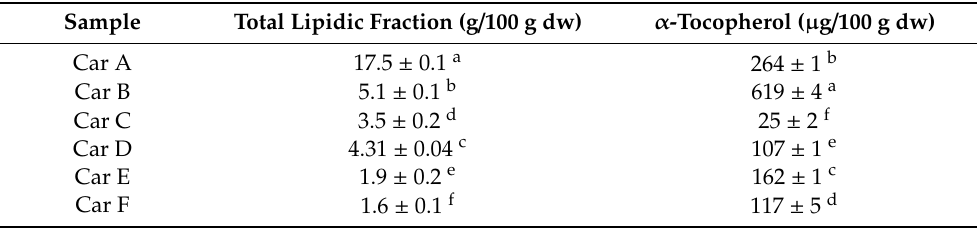
Table 1. Lipidic fraction and tocopherols of Cynara cardunculus heads at various stages of maturity (mean ± SD; n = 3).